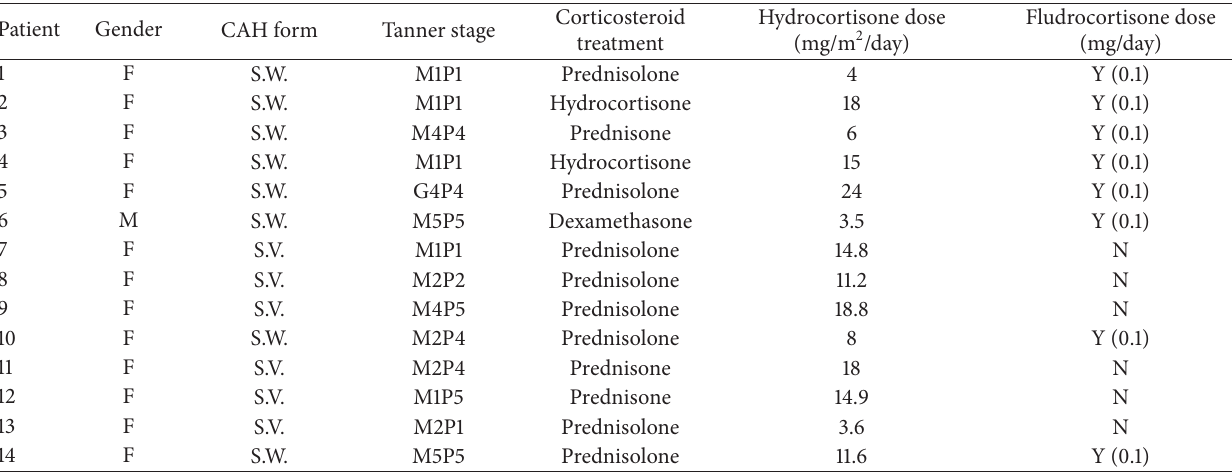
Table 2: Patient characteristics according to gender, congenital adrenal hyperplasia form, Tanner stage, type of corticosteroid treatment, hydrocortisone dose equivalent, and use of fludrocortisone.